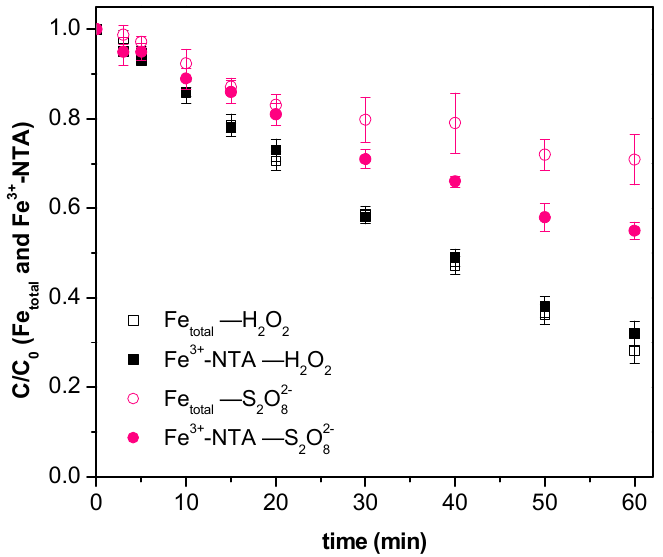
Figure 5. Normalized concentration of Fe total precipitation and Fe 3+ –NTA photodecomposition by UVC-LEDs. Operating conditions: 0.10 mM of Fe 3+ –NTA at a 1:1 molar ratio, and 1.47 mM of each of the oxidants (H 2 O 2 and S 2 O 82 − ).